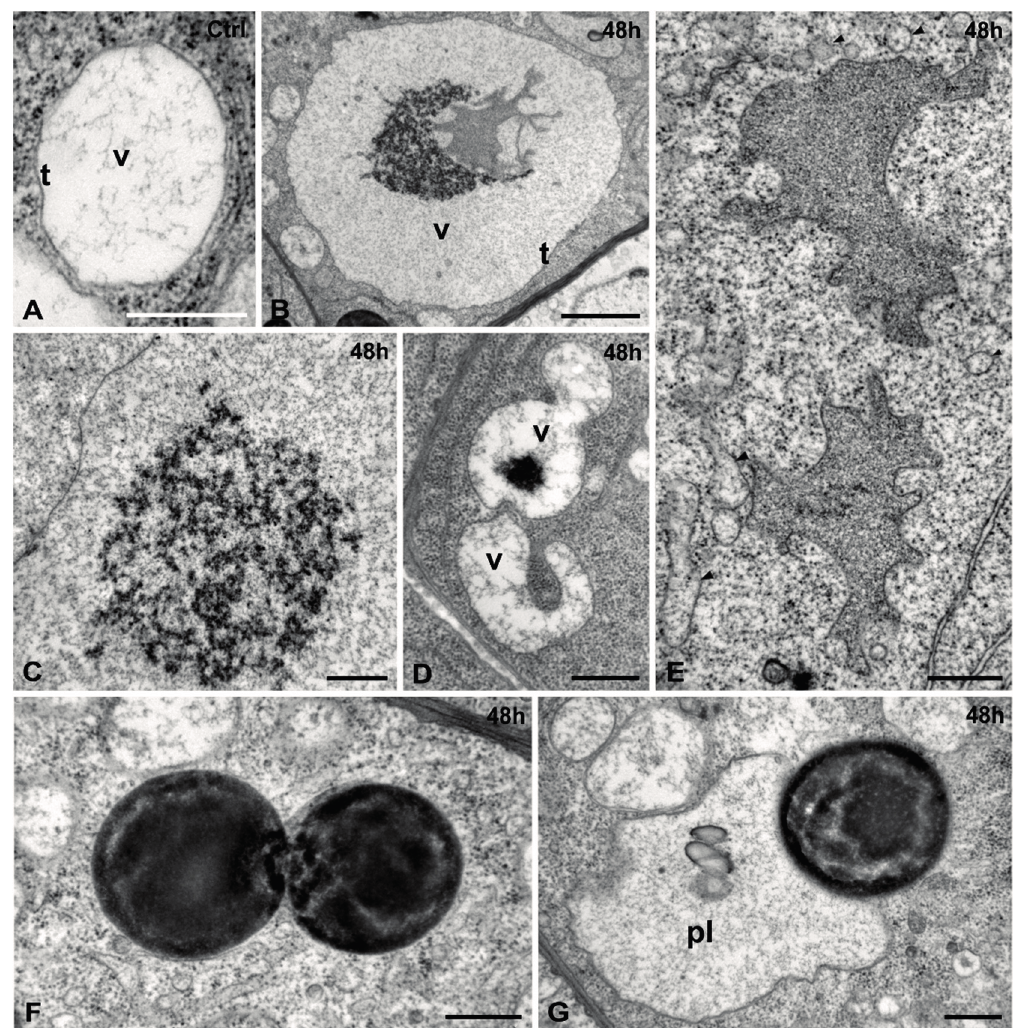
Figure 8. ( A – E ) Cr(VI) effects to the vacuoles. ( A ) Control. A small vacuole (v) with smooth tonoplast (t) and a few fibrillar contents; ( B – E ) 48 h Cr(VI)-treatment; ( B ) A vacuole with intact tonoplast (t), a central accumulation of electron dense material capping a grayish membrane-bound body with an irregular shape, and fine granular material throughout the vacuole volume; ( C ) Spherical augmentation of granular material within a vacuole; ( D ) Two vacuoles (v) with unusual shape and contents; ( E ) Two membrane-bound irregular structures containing dense granular material, presumably resulted from vacuoles contraction. They are surrounded by cytoplasmic ribosomes and variously shaped vesicles (arrowheads); ( F , G ) 48 h treatment. Endocytoplasmic opaque bodies of spherical shape and uneven density, either approaching each other ( F ) or intimately appressed to a plastid (pl) ( G ). Scale bars: ( A , D , E – G ): 0.5 μ m; ( B ): 2 μ m; ( C ): 1 μ